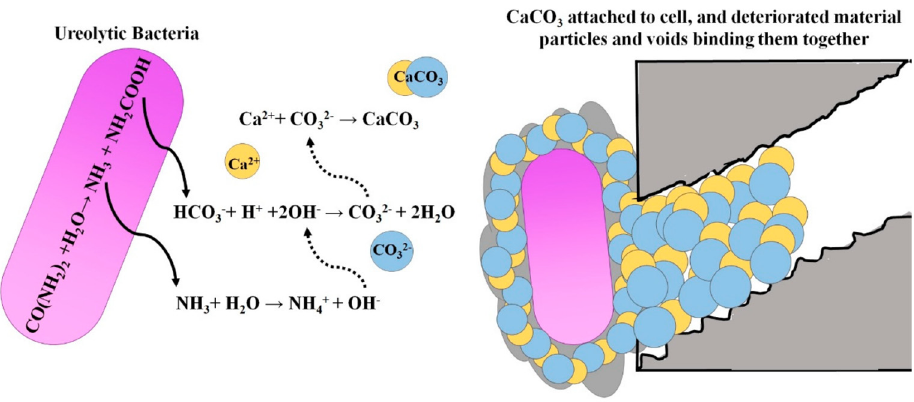
Figure 1. The mechanism of MICP repairing concrete defects.